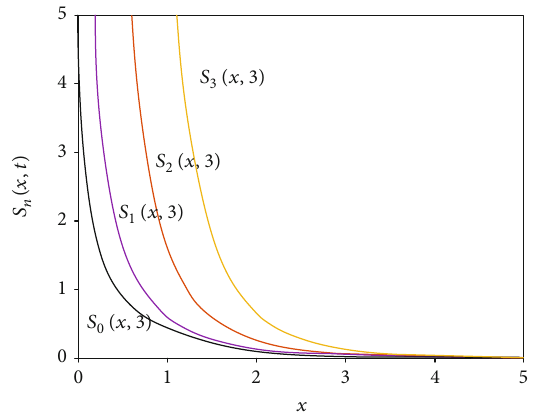
x , t Þ against real argument x > 0 for various values of Figure 2: S n ð integer order n at t = 3